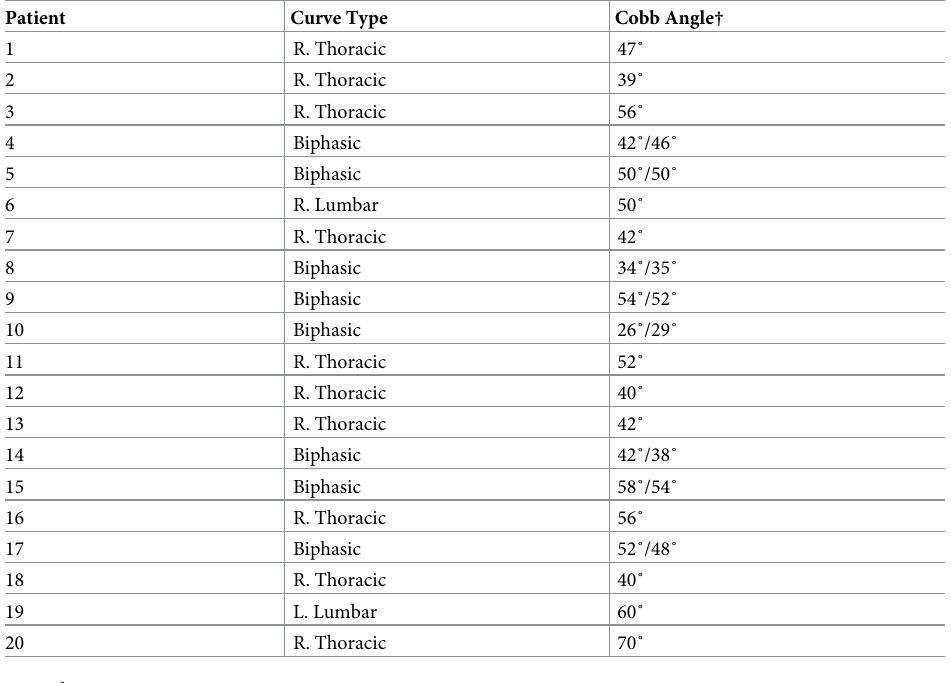
Table 1. Scoliosis curve patterns. Patient Curve